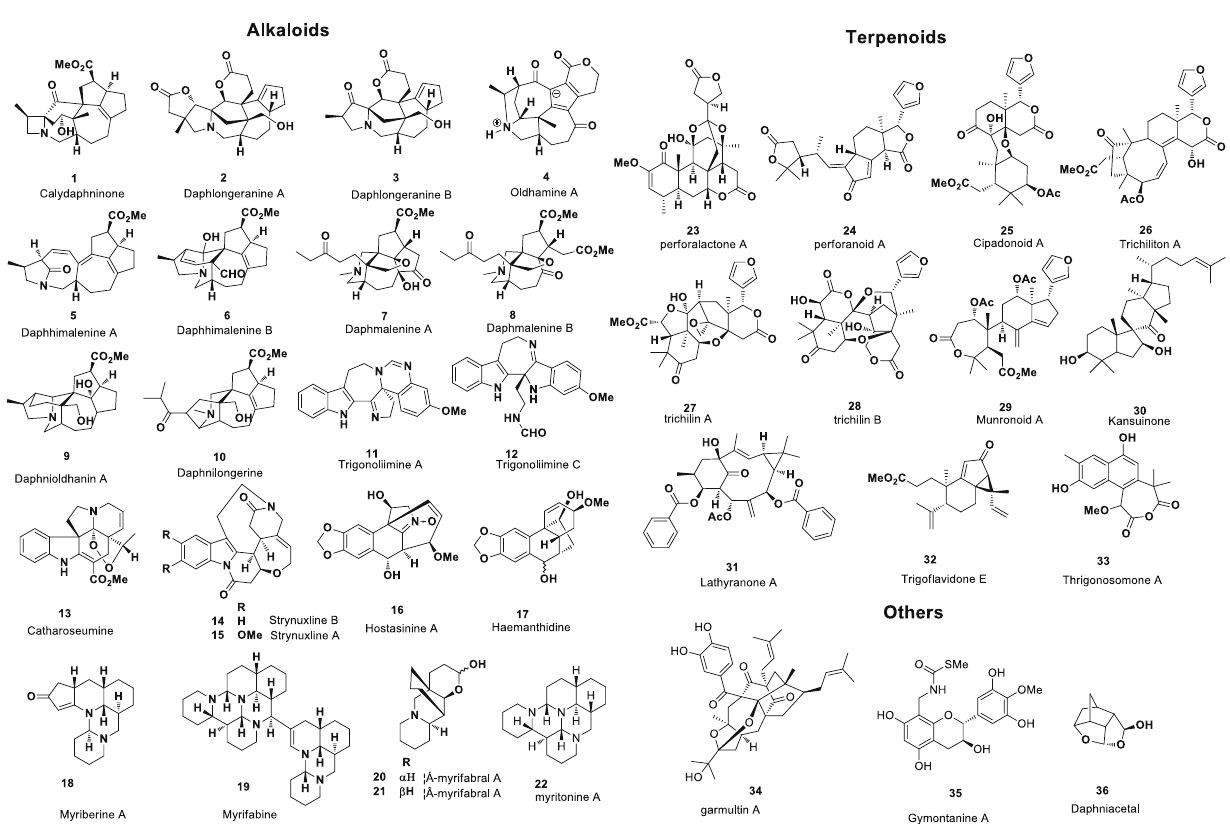
Fig. 1 Thirty six natural products from the Hao’s group were cited by ‘‘Hot off the Press’’ of Natural Product Reports